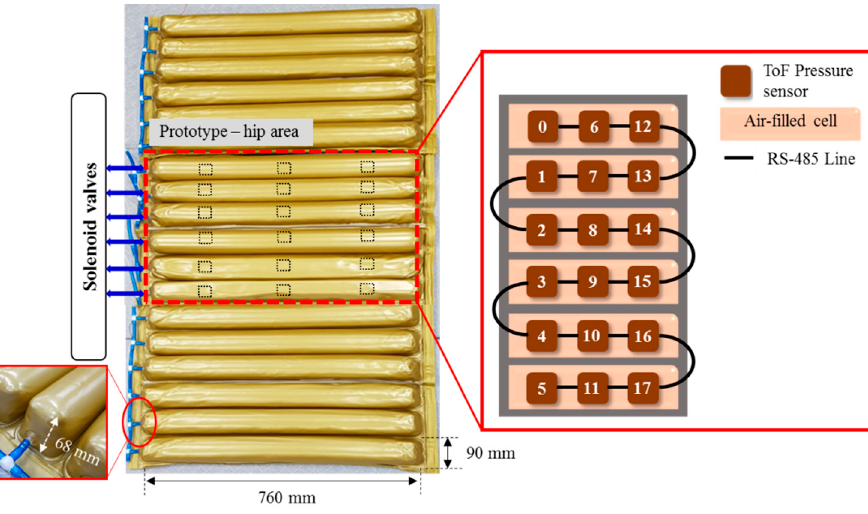
Figure 4. Description of pressure sensor location in air-filled cells of the mattress. The right inset shows the connection diagram of sensors with different addresses from 0 to 17. The left inset shows the hose pipe connected with the side of the air-filled cell.